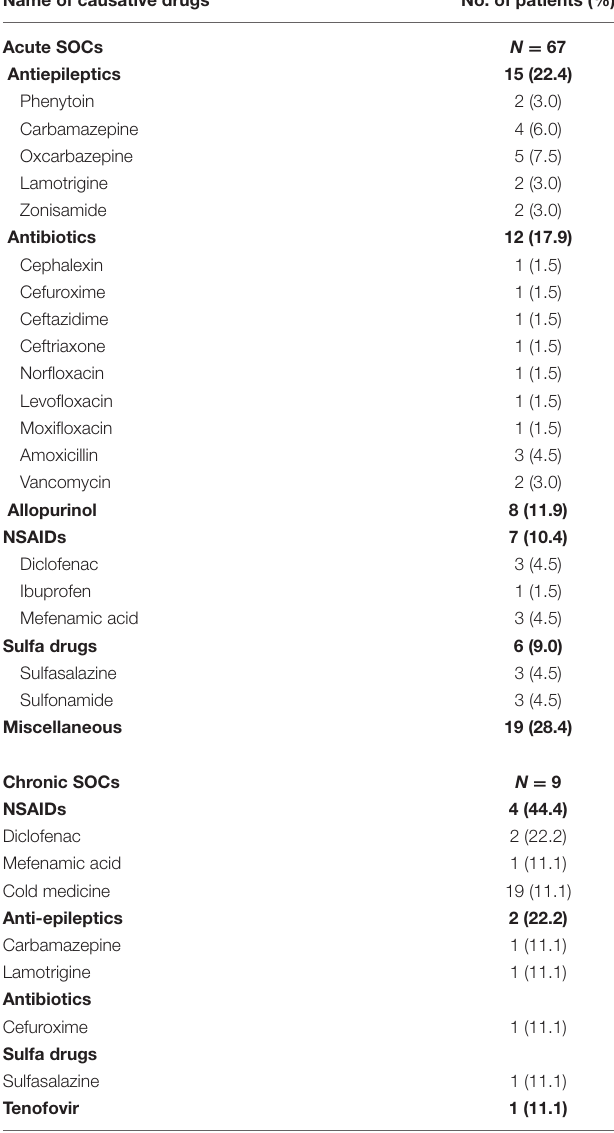
TABLE 2 | Top 5 causative drug categories responsible for acute and chronic SOCs in SJS/TEN patients. Name of causative